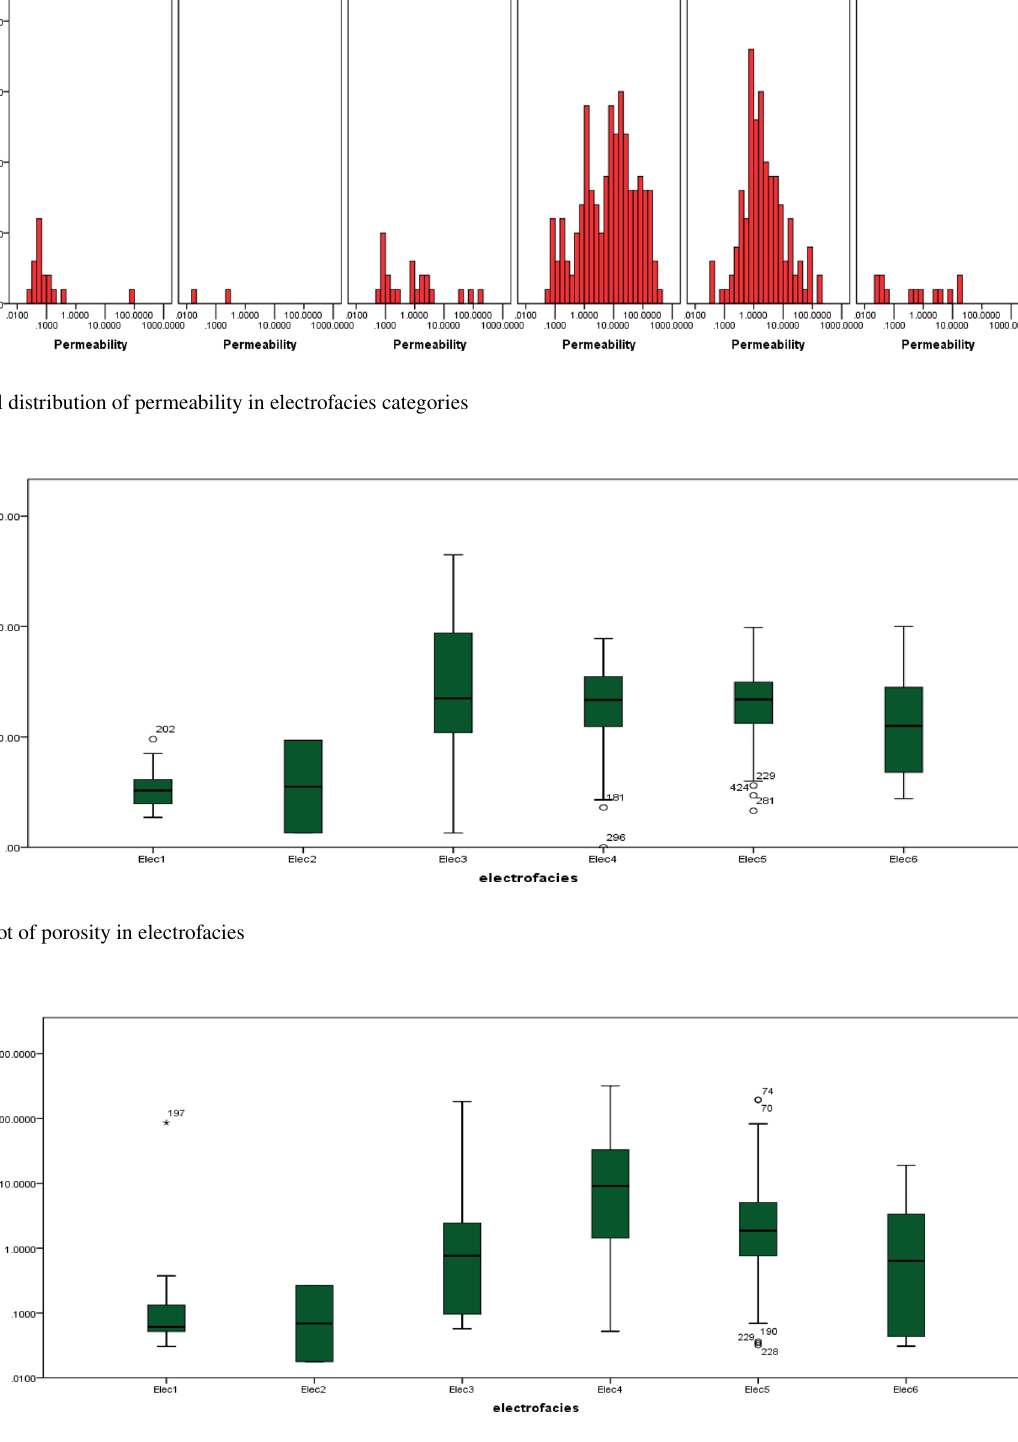
Fig. 6 Box plot of permeability in